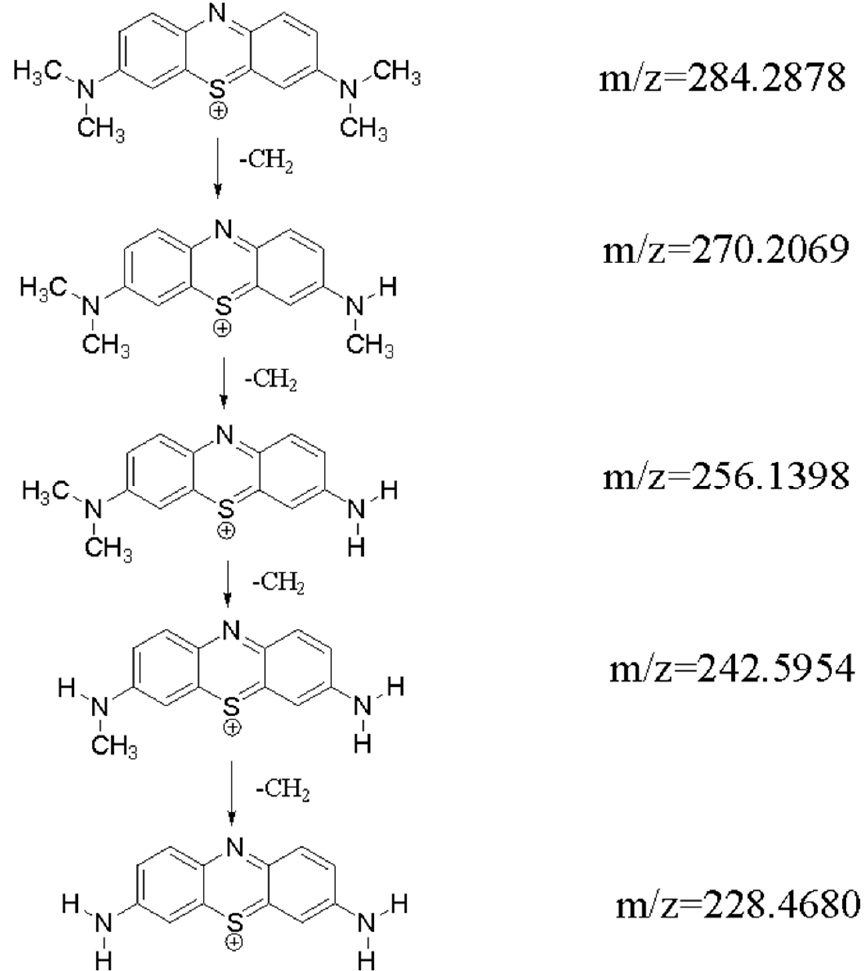
Figure 11. Degradation pathway of MB.